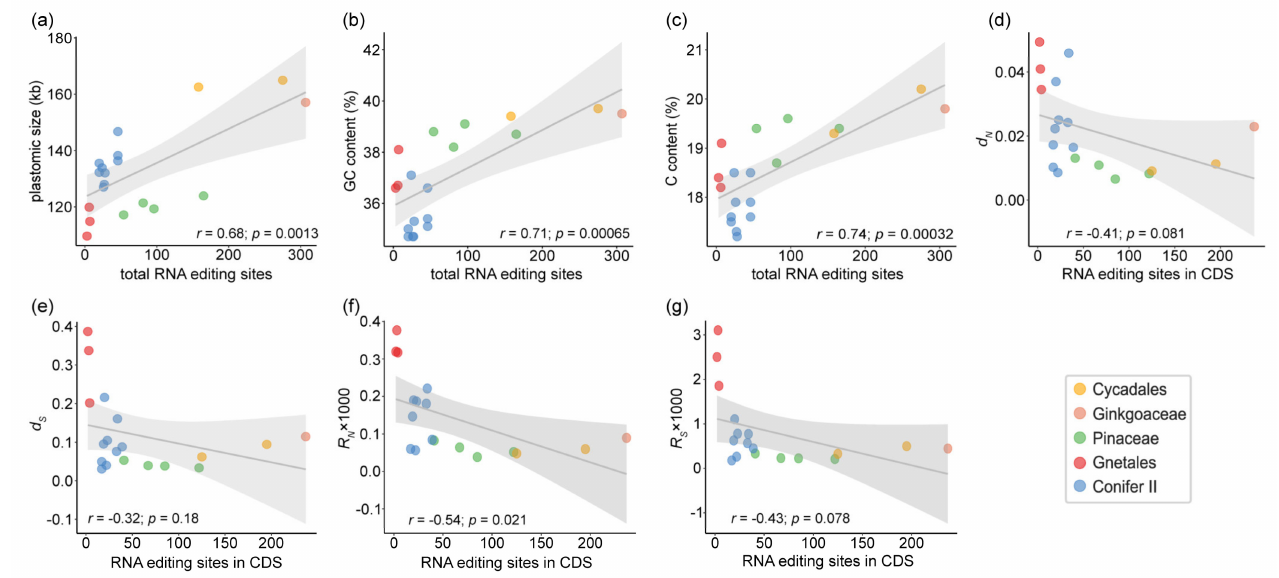
Figure 8. Correlation between the number of chloroplast RNA editing sites and some factors. ( a ) Plastomic size; ( b ) GC content; ( c ) C content; ( d ) dN (nonsynonymous substitution rates); ( e ) dS (synonymous substitution rates); ( f ) RN × 1000 ( RN : absolute nonsynonymous substitution rates per branch); and ( g ) RS × 1000 ( RS : absolute synonymous substitution rates per